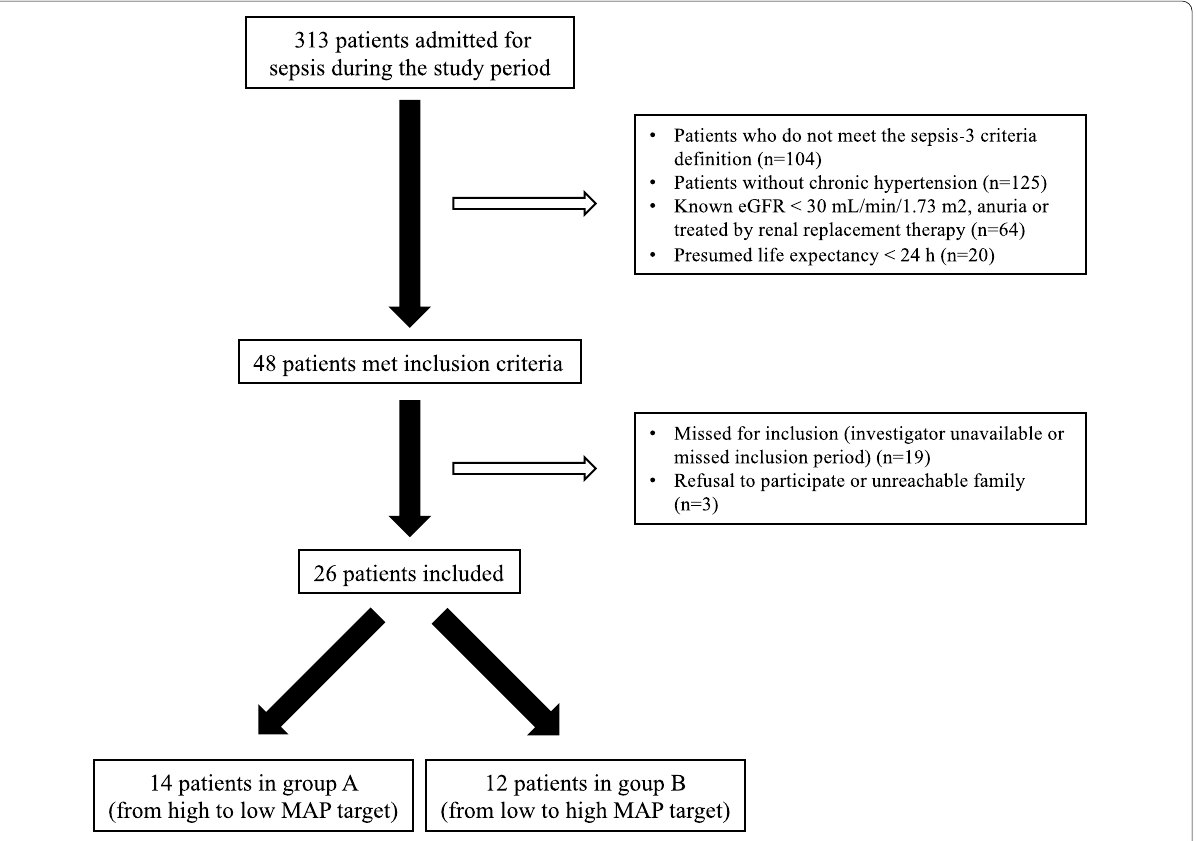
Fig. 2 Flow chart of the